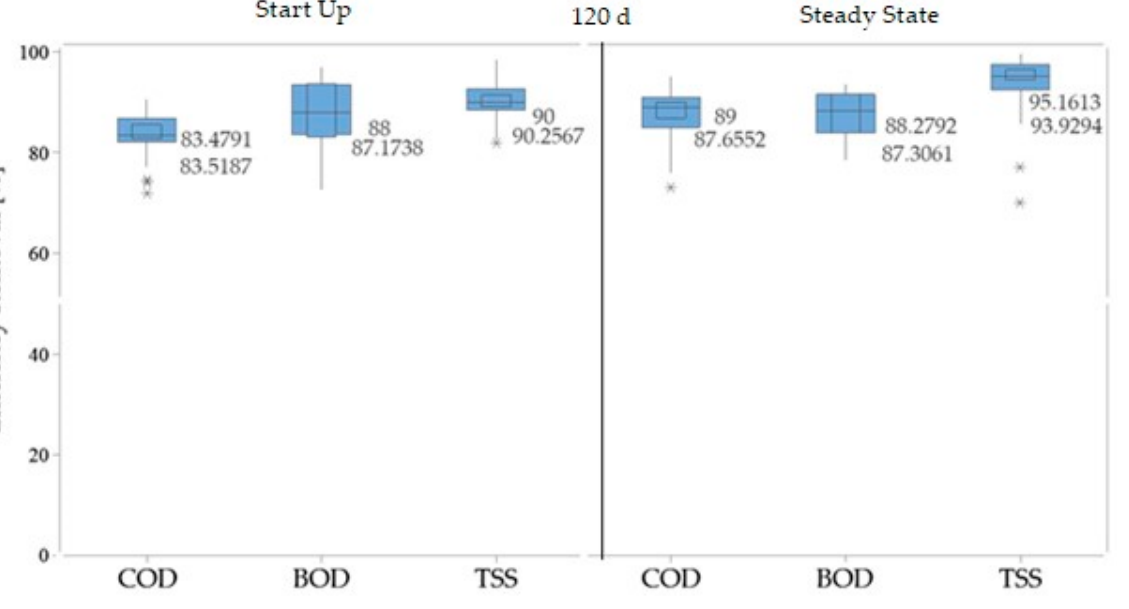
Figure 7 . COD, BOD, and TSS STP removal efficiencies during the start-up and steady state. *: boxplot outliers *: boxplot